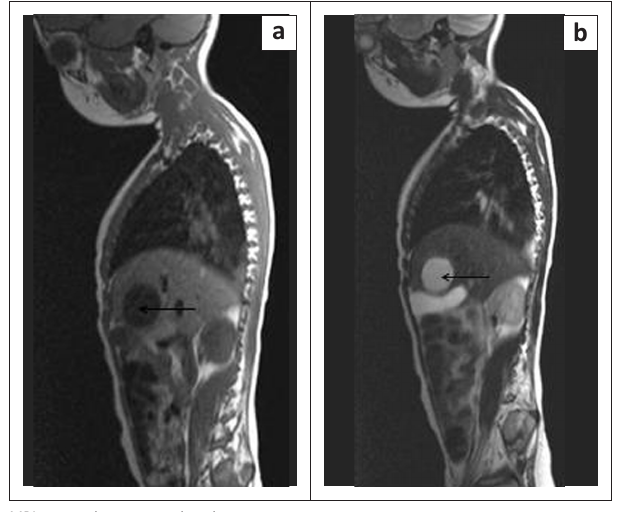
MRI, magnetic resonance imaging. FIGURE 5: (a) and (b) Sagittal T1 and T2 weighted MRI images showing cystic lesion in segment 4 of the liver